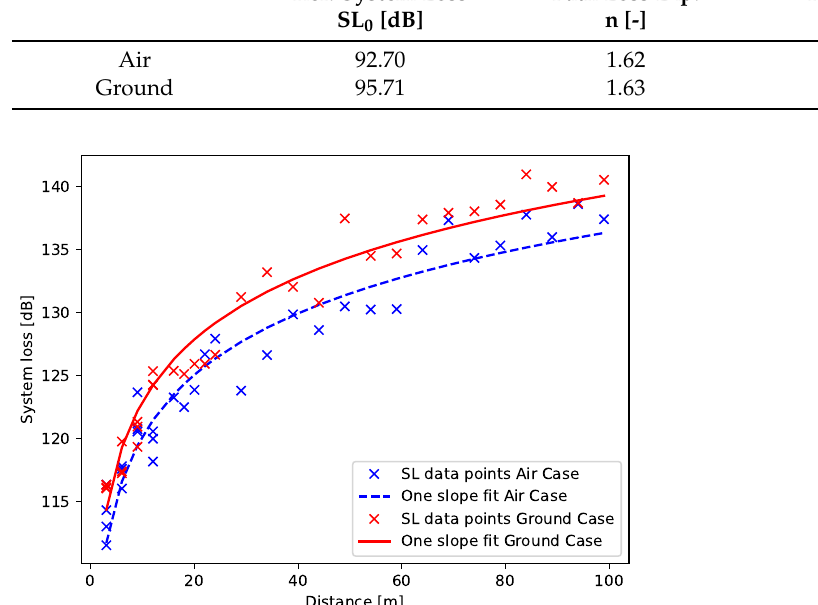
Table 3. The propagation coefficient and fading margin for the air and ground case. Ref. System Loss Path Loss Exp. Fitting Error